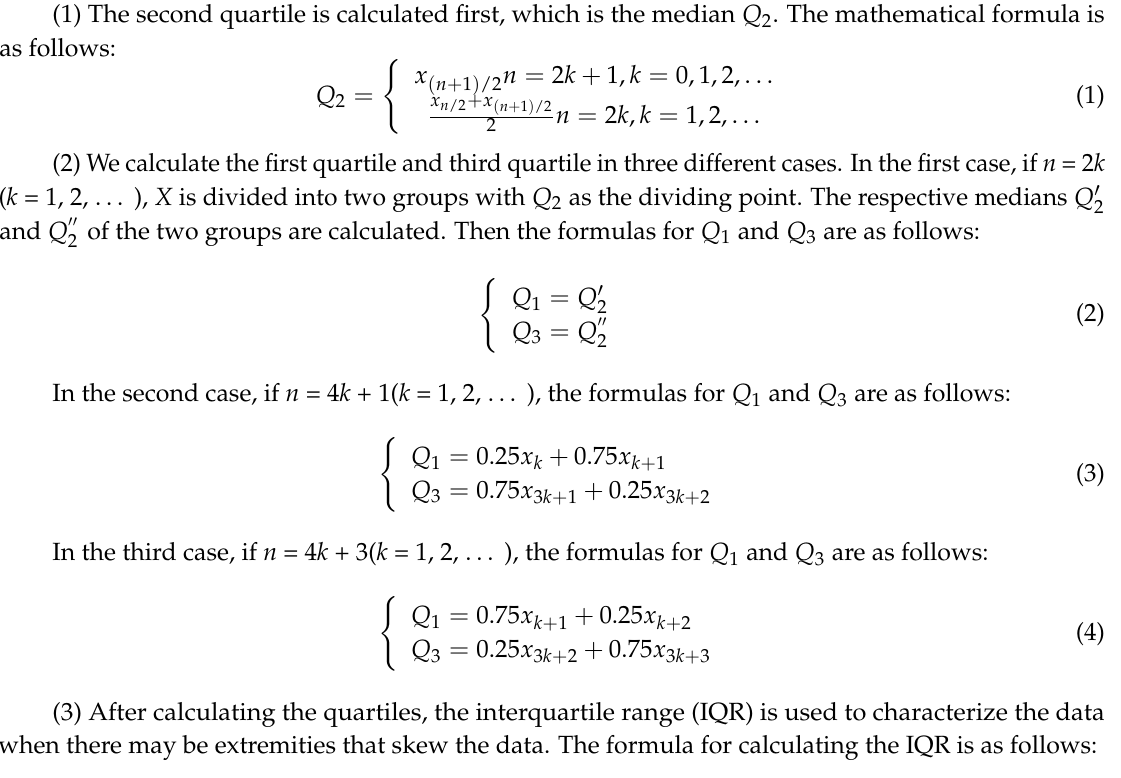
Figure 4. The principle of quartiles.